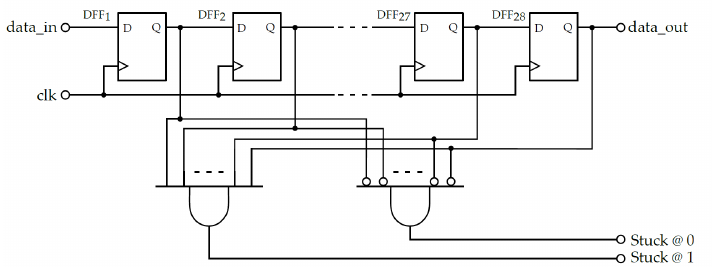
Figure 14. Hardware implementation of the repetition count test for a binary random source.